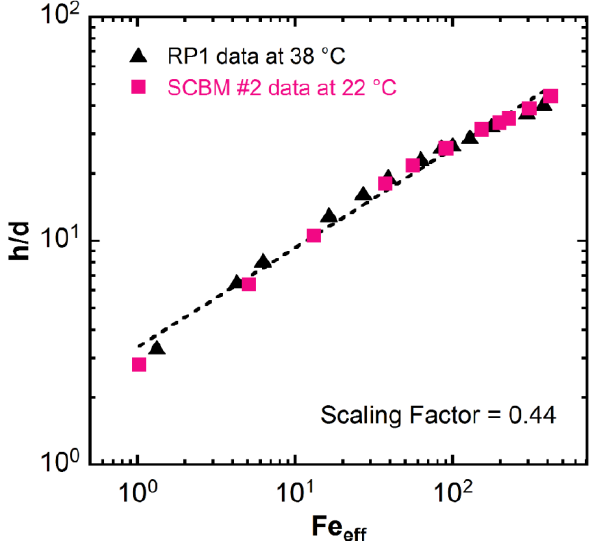
Figure 7. The unitless depth of penetration ( h / d ) as a function of the effective elastic Froude number Fe eff for the RP1 at 38 °C and SCBM at 22 °C. Data are from Edwards et al. [15].